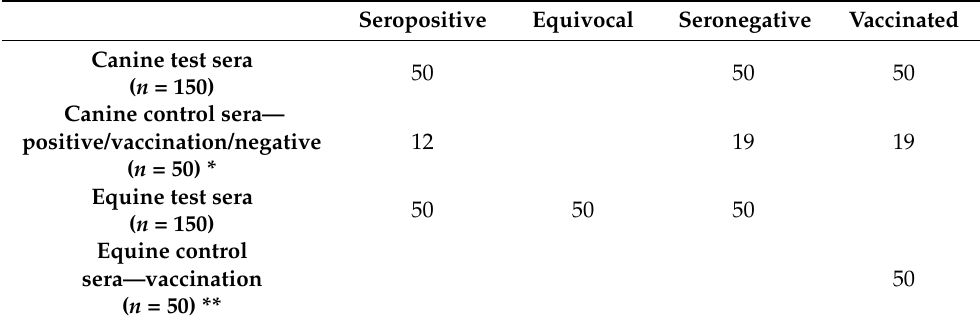
Table 1. Serostatus of canines and equines used in this study. Seropositive Equivocal